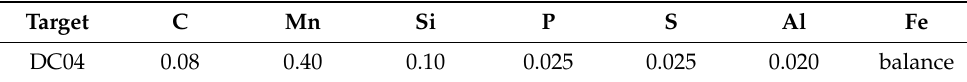
Table 2. Chemical composition (max. %at.) of DC04 steel (target)